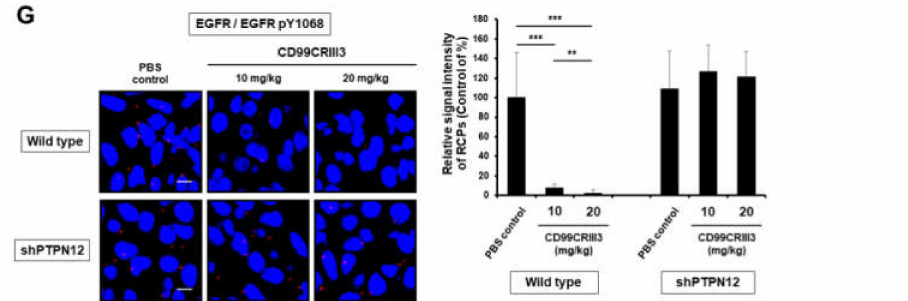
Figure 7. Evaluation of the in vivo e ffi cacy of CD99CRIII3 in the xenograft model of human breast cancer. ( A ) MDA-MB-231 cells were transiently transfected with PTPN12 shRNA plasmid. Cell extracts were assessed by Western blot analysis to determine the phosphorylation levels of EGFR at Y1068 or FAK at Y397. β -actin was used as a loading control. The uncropped Western blots have been shown in Figure S8. ( B ) Comparison of cell growth rate between wt-MDA-MB-231 and shPTPN12-MDA-MB-231 cells. ( C ) Images of tumor xenografts. Scale bar represents 10 mm. ( D , E ) Graph shows the mean di ff erence in tumor volume and weight between wild-type and PTPN12 knockdown cells. Lines indicate statistical comparisons, and significant di ff erences between treatments are shown by asterisks as follows: * p < 0.05; ** p < 0.01. ( F ) Hematoxylin and Eosin (H&E) staining of tumor xenografts. Scale bar represents 10 µ m for 400 × magnification. The expression levels of EGFR, PTPN12, and Ki67 by IHC in xenografts. ( G ) In situ PLA analysis was performed to determine the dimerization pattern of EGFR within xenograft tumor tissues. Confocal images were taken from four tumors of each treatment group and displayed in compressed z-stack form. Numerical values are the mean intensities ( ± SD) of red spots in three randomly selected fields per tumor section. Significant di ff erences between treatments are shown by asterisks as follows: ** p < 0.01; *** p < 0.001. Scale bar, 10 µ m (600 × ). wt, wild type; sh, short hairpin. ( H ) Schematic model for the inhibitory e ff ect of CD99 agonistic ligand on EGF-induced activation of